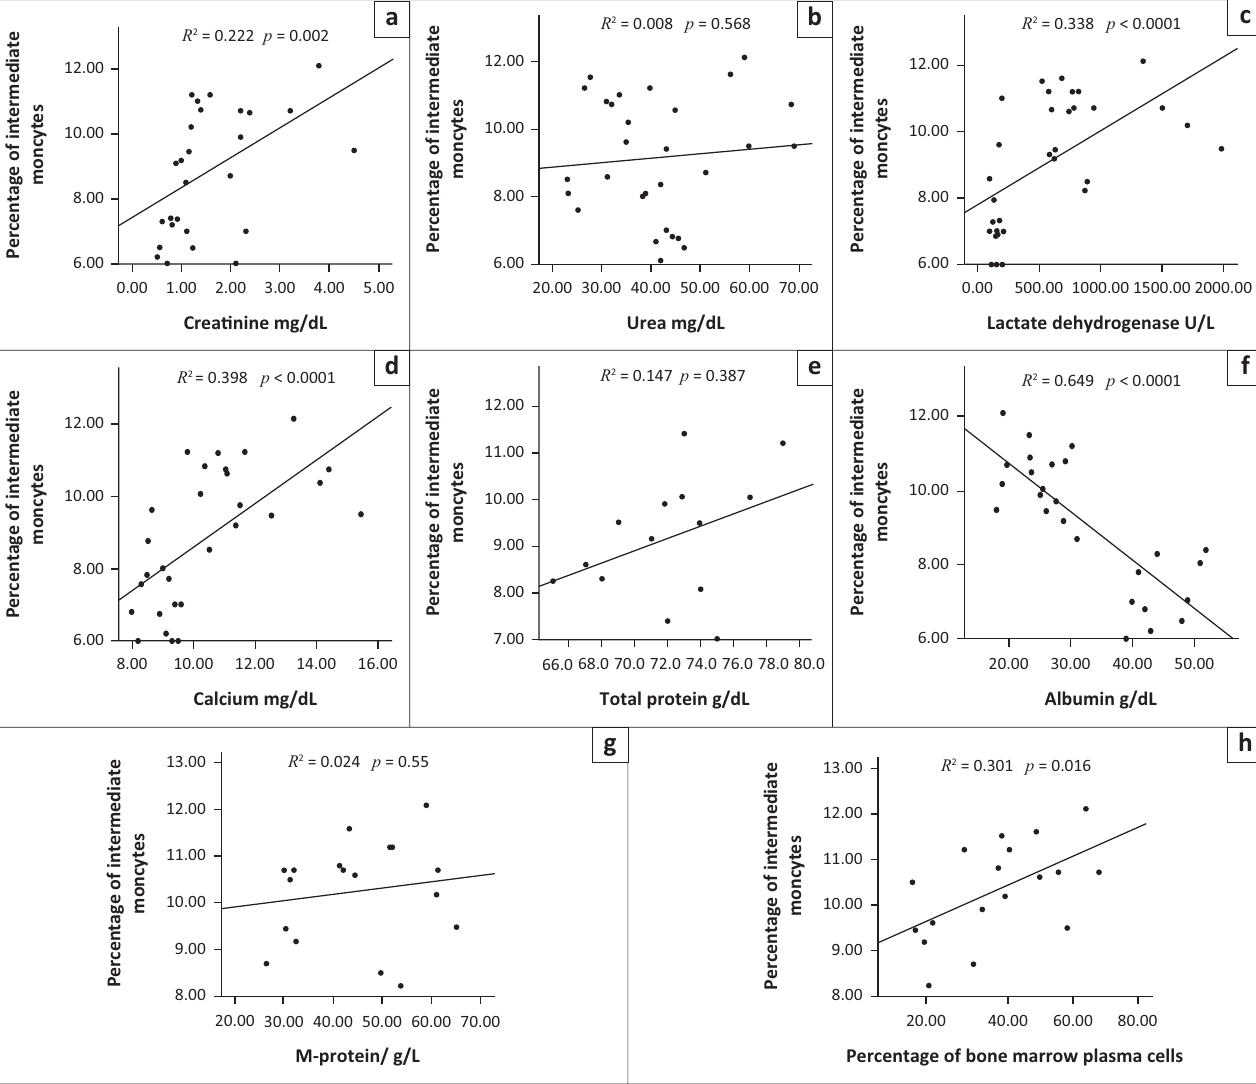
U/L, units per litre. FIGURE 4: Correlation of intermediate monocytes with laboratory parameters in multiple myeloma patients and healthy controls at Assiut University, Assiut, Egypt, from October 2018 to August 2019 . The percentage of intermediate monocytes (CD16 + CD14 ++ ) and (a) creatinine, (b) urea, (c) lactate dehydrogenase, (d) calcium, (e) total protein, (f) albumin, (g) M-protein, and (h) bone marrow plasma cells % were correlated using Spearman’s correlation test and correlated negatively with level of serum albumin ( R 2 = 0.649, p < 0.0001) (f), and correlated positively with levels of serum creatinine ( R 2 = 0.222, p = 0.002) (a), lactate dehydrogenase ( R 2 = 0.338, p < 0.0001) (c), calcium ( R 2 = 0.398, p < 0.0001) (d), and the percentage of bone marrow plasma cells ( R 2 = 0.301, p = 0.016)